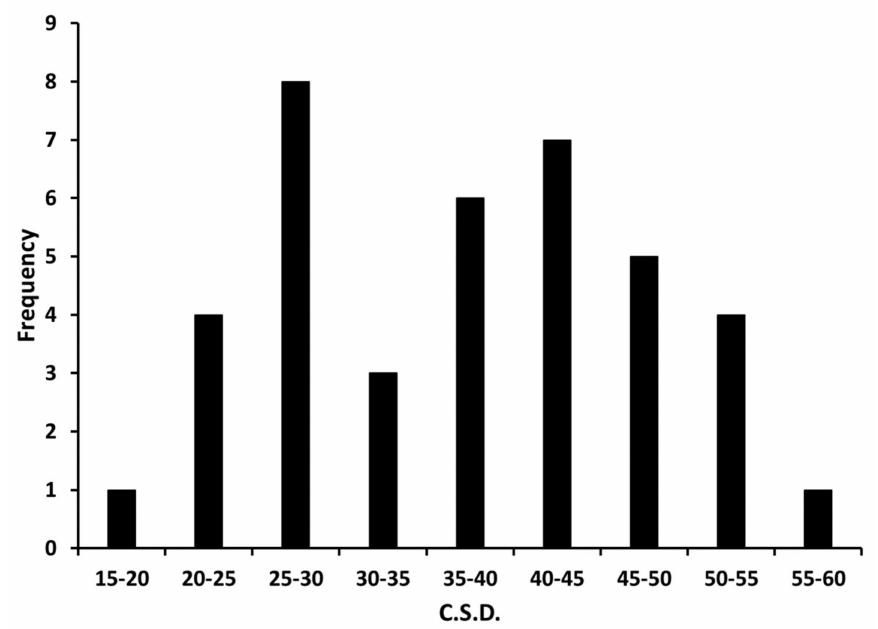
Figure 6. Frequency histogram of the 39 individual determinations of circular standard deviation (c.s.d.) for codling moth foraging for pheromone plumes in a Michigan apple